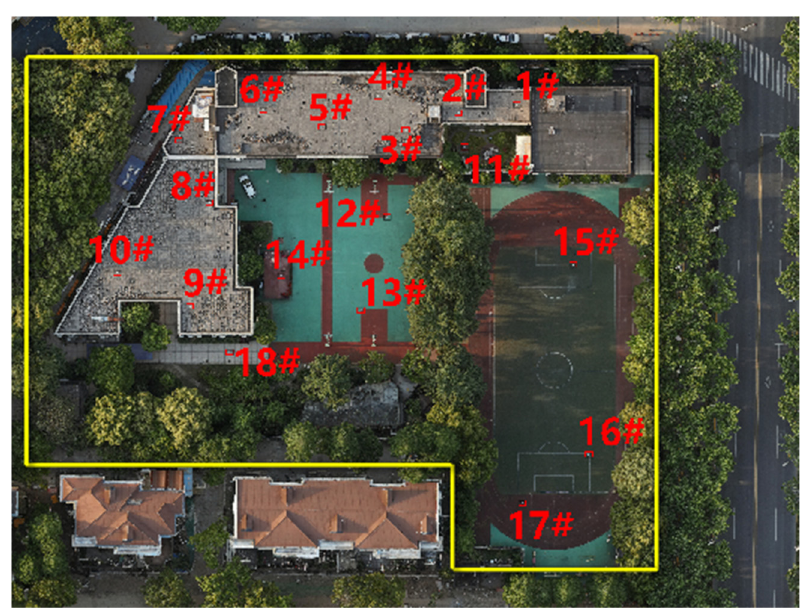
Figure 3. Target spatial position distribution. (1# , 2# , 3#...... represents the number of the target.)